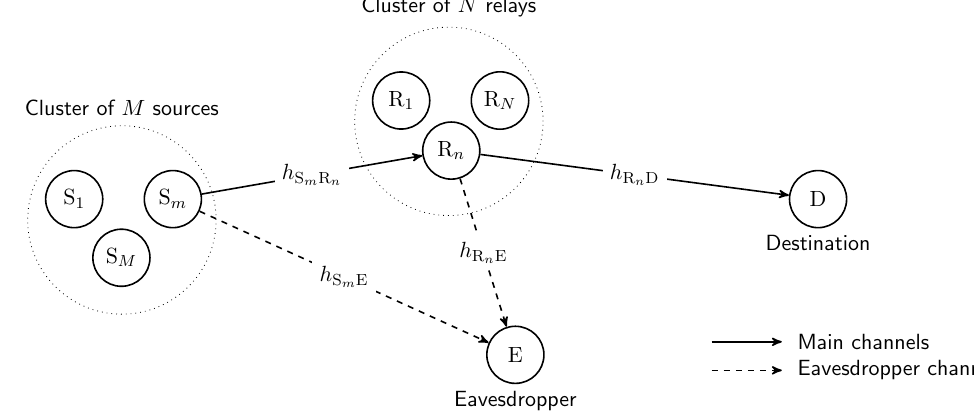
Figure 1. Schematic illustration of the multiuser multirelay cooperative networks with the presence of an